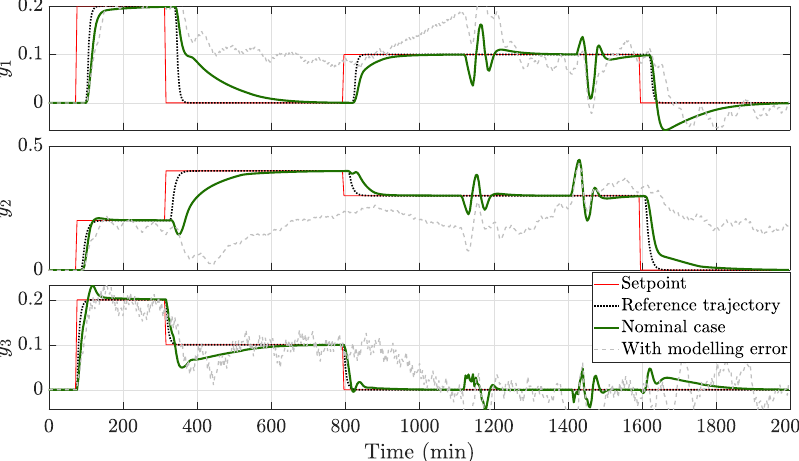
Figure 9. Case 1—Response of the HOF outputs to setpoint changes and disturbance rejections.